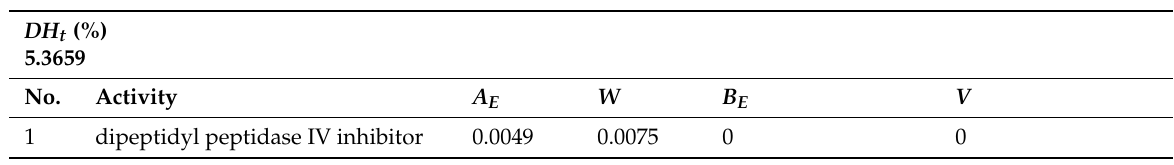
Table A24. A E , DH t , W , B E and V values from RubisCO of Halophila stipulacea . In silico enzymatic cleavage was carried out by